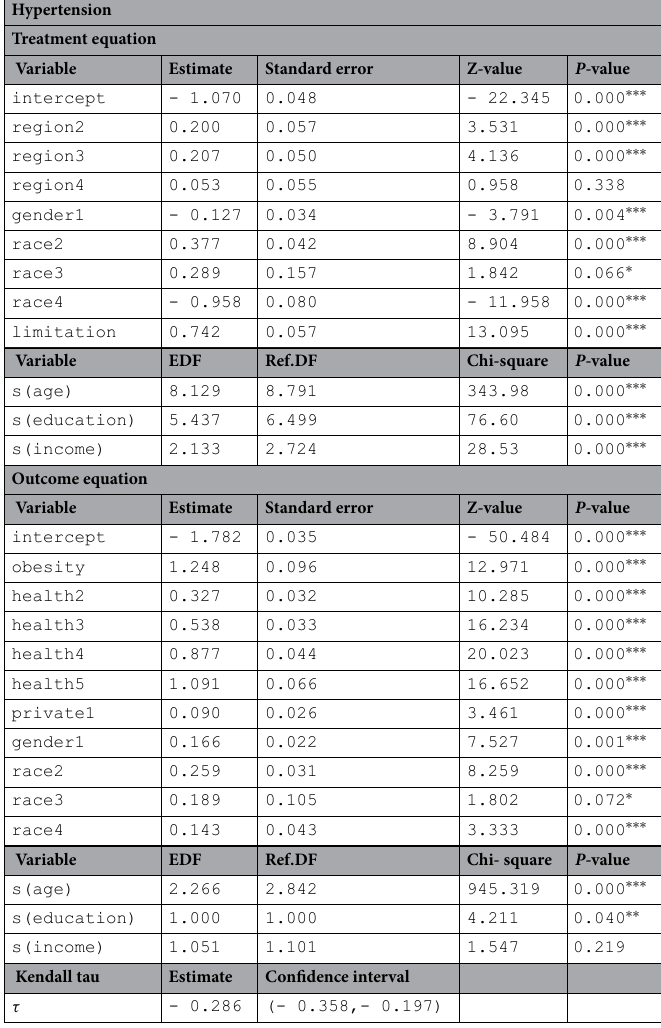
Table 4. Estimated coefficients and standard errors of the parametric and non-parametric components of the Plackett copula ( PL ) for the treatment and outcome equations for hypertension. 95% for confidence intervals for τ have been obtained using the methods described in Section “Semiparametric recursive bivariate